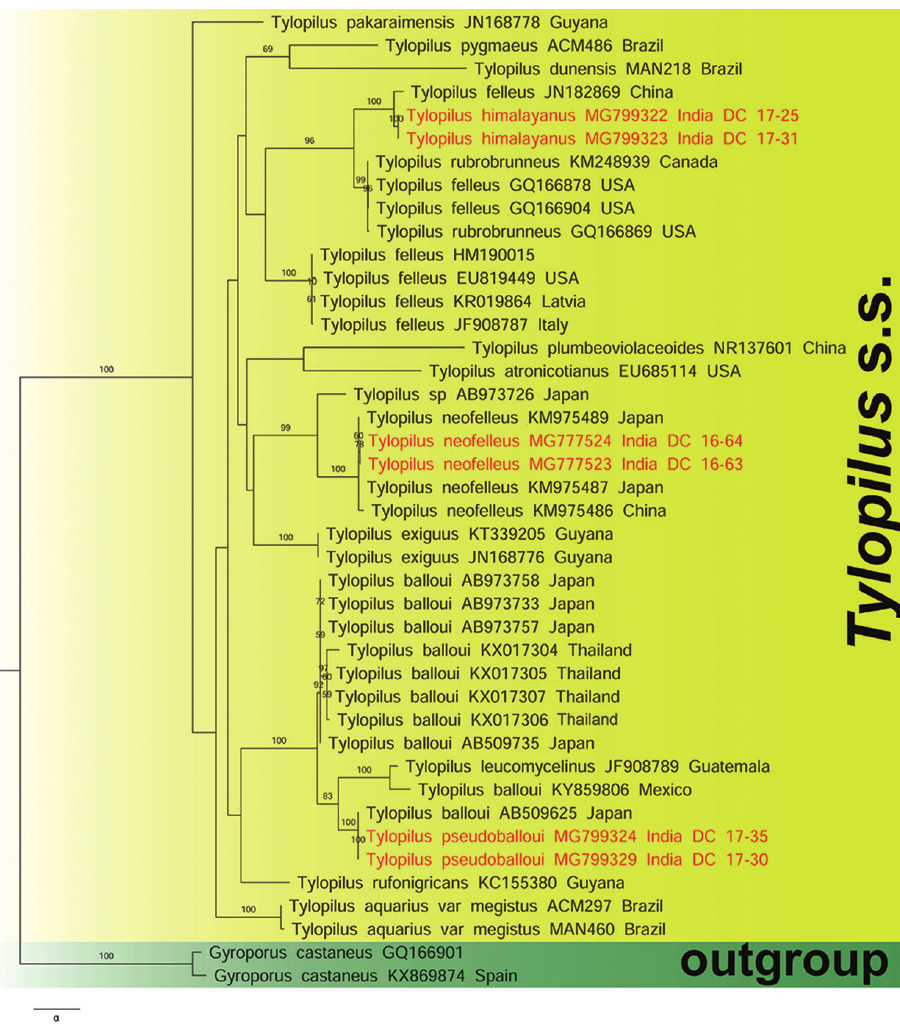
Figure 2. nrITS based phylogram generated from Maximum Likelihood (ML) analysis under GTR- GAMMA substitution model depicting the placement of Tylopilus neofelleus, T. pseudoballoui and T. hima- layanus within Tylopilus s.s. Two sequences of Gyroporus castaneus were used as outgroup. ML Bootstrap percentage (MLB) derived from this analysis (MLB >50%) are shown above or beneath the branches. Two novel species and a new record for Indian mycobiota are highlighted in bold and red font. GenBank acces- sion no. and country name (when available) for each species are shown after the species